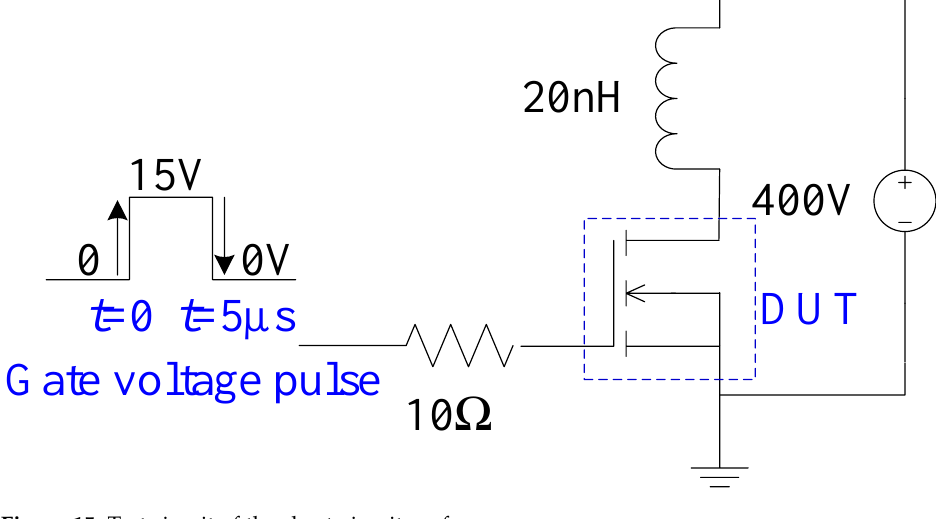
Figure 15. Test circuit of the short-circuit performance.